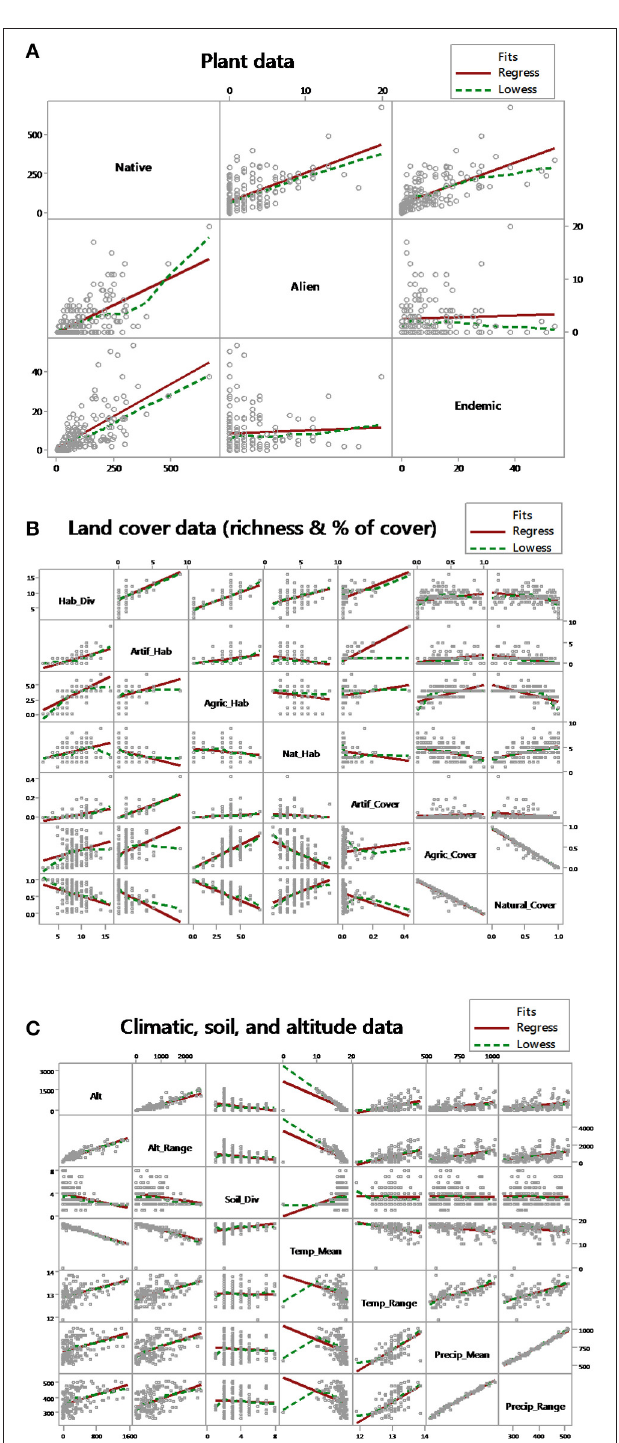
FIGURE 1 | Initial data mining: (A) exploring the relationship between species richness data (described in the main text, methods “Plant data”) (B) land cover indices (described in the main text, methods “Land cover data”), and (C) environmental and climatic data (described in the main text, methods “Climatic, soil, and altitude data”) with multi-scatter plots. Grey circles indicate data points, solid red lines linear regression, and dashed green lines a lowess smoother between each two data